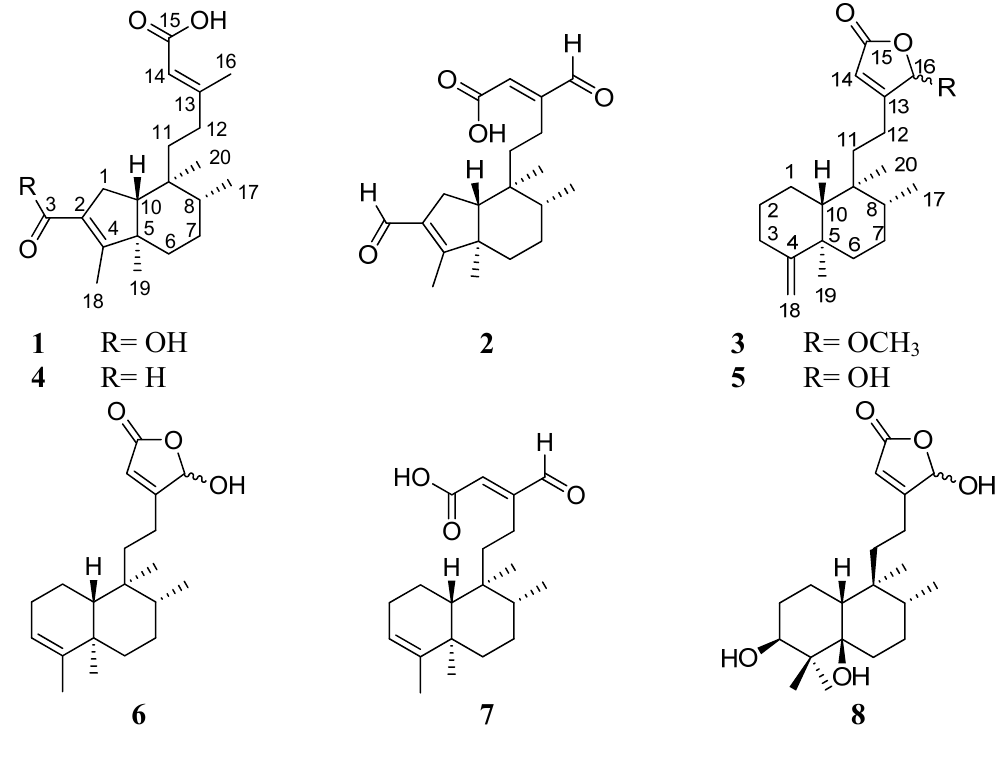
Figure 1. Compounds 1 – 8 isolated from the Indian Mast Tree Polyalthia longifolia var. pendula